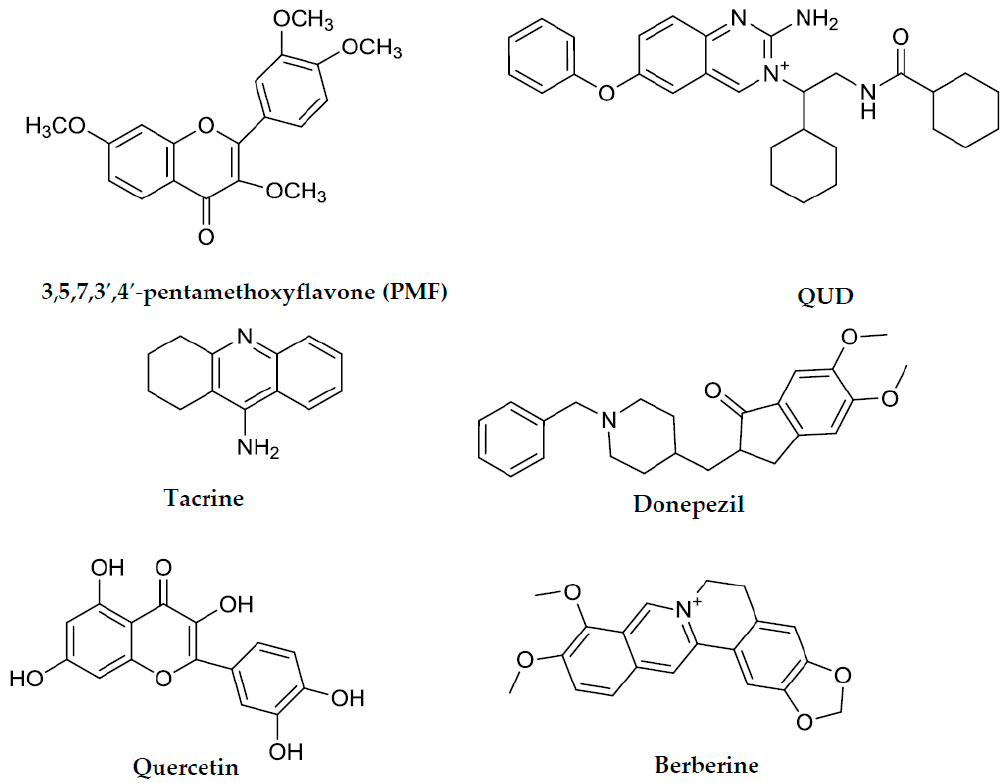
Figure 2. Structures of the positive controls used in in vitro assays and in silico molecular docking analysis.